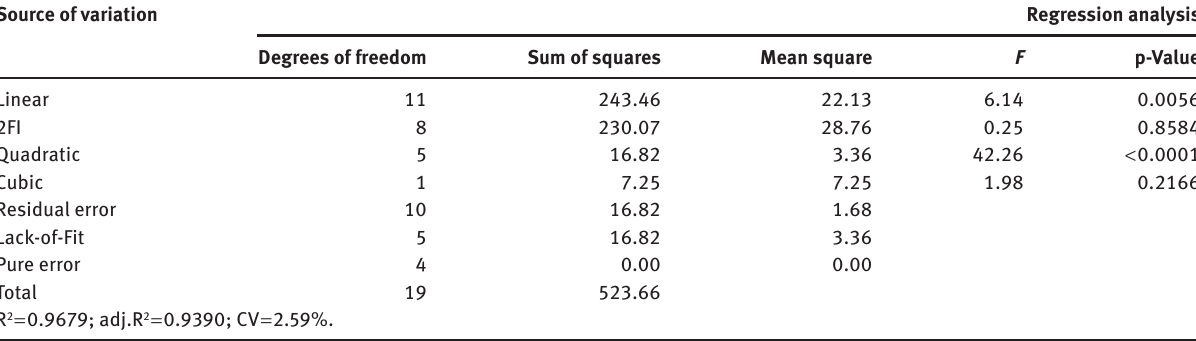
Table 3: Analysis of variance for the quadratic model. Source of